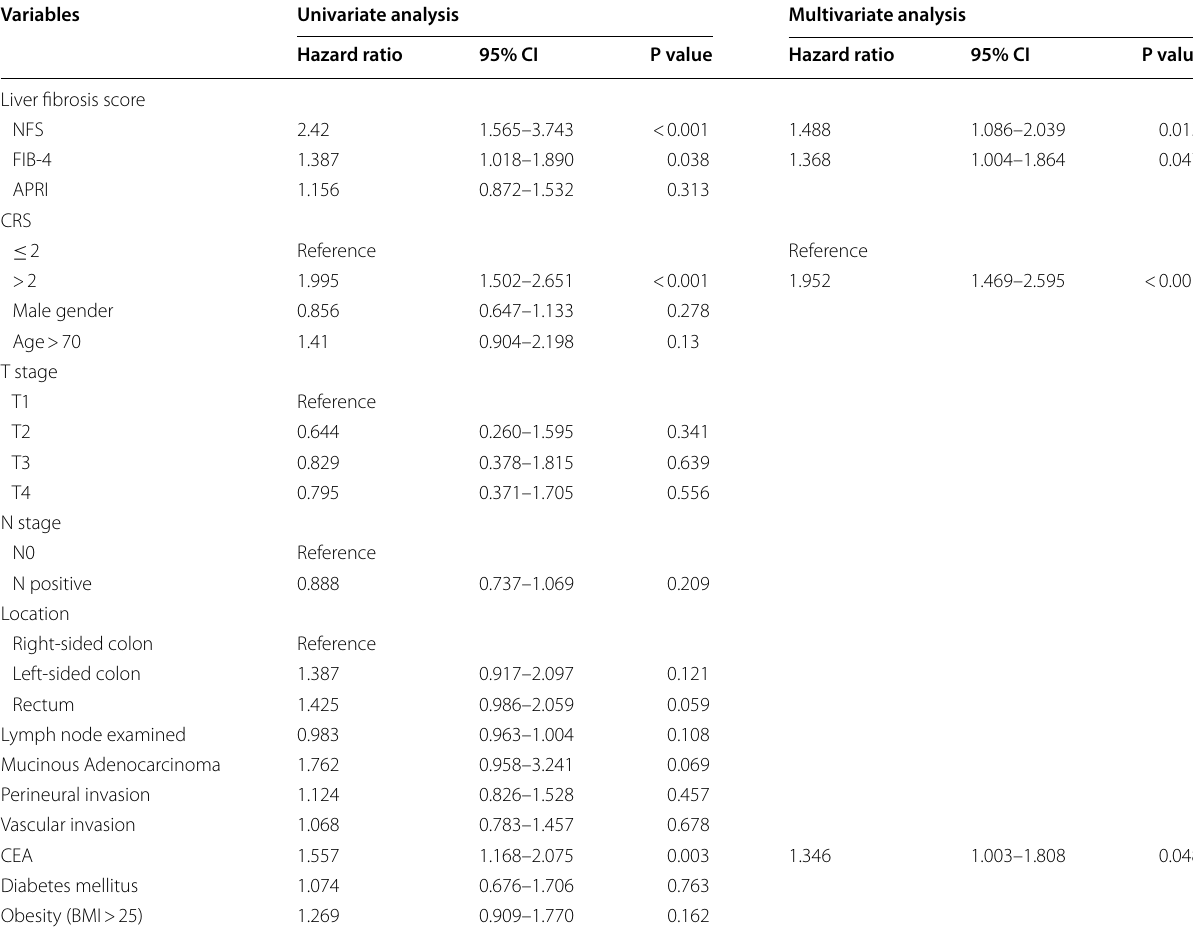
Table 6 Risk factors for liver relapse postoperatively